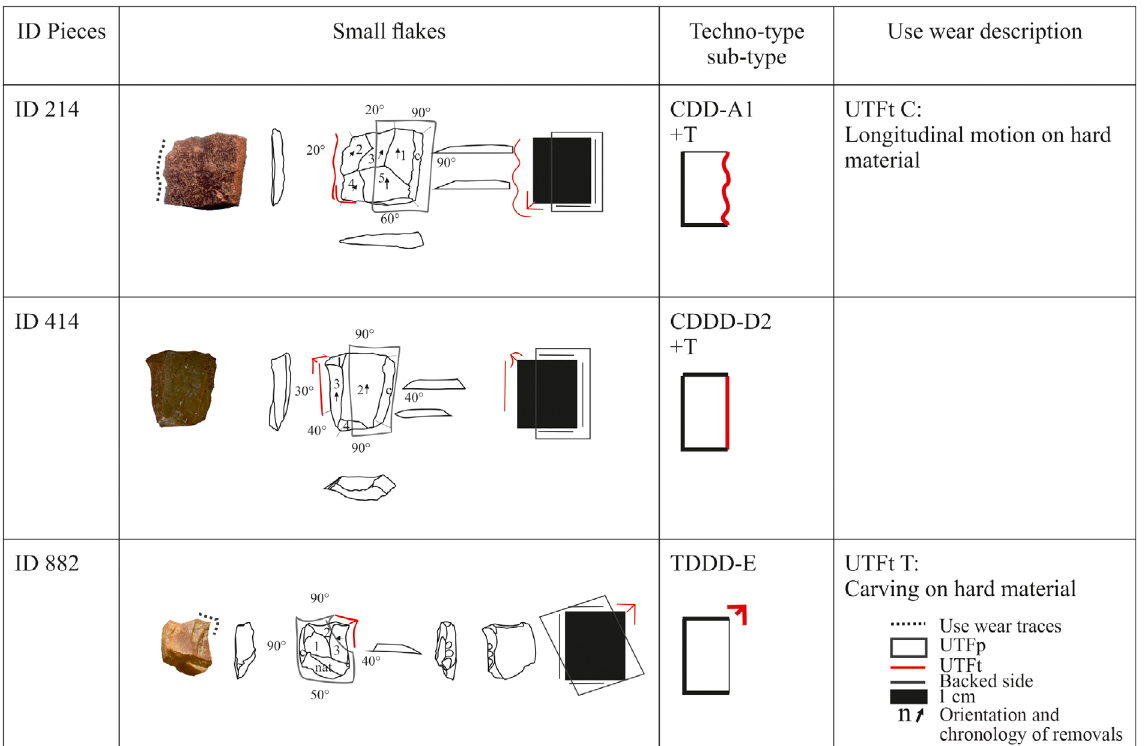
Figure 14. Techno-functional analysis and description of use wear traces of the small flakes.